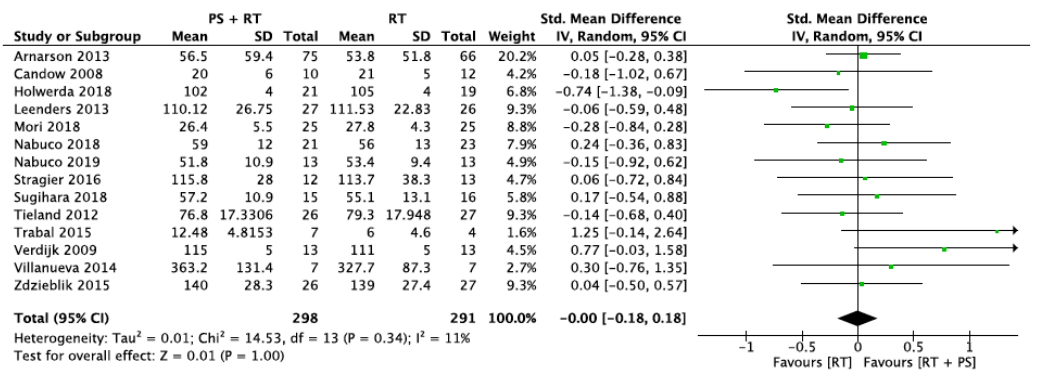
Figure 4. Impact of RT + PS on lower-limb strength.